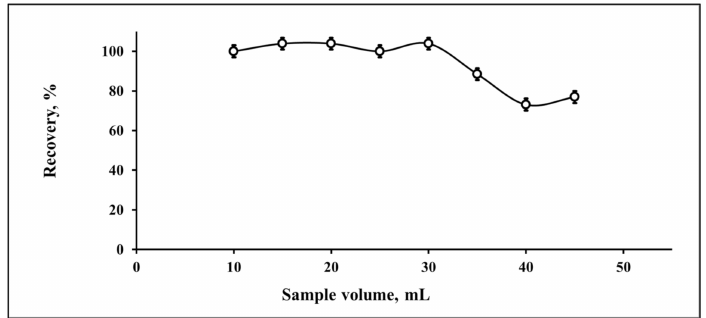
Figure 3. Evaluation of the sample volume for the deep eutectic-based microextraction of Pb(II) ( n = 3).